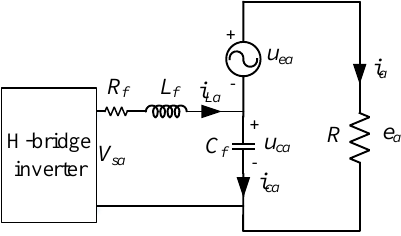
Figure 2. Equivalent diagram of H-bridge A in series converters.